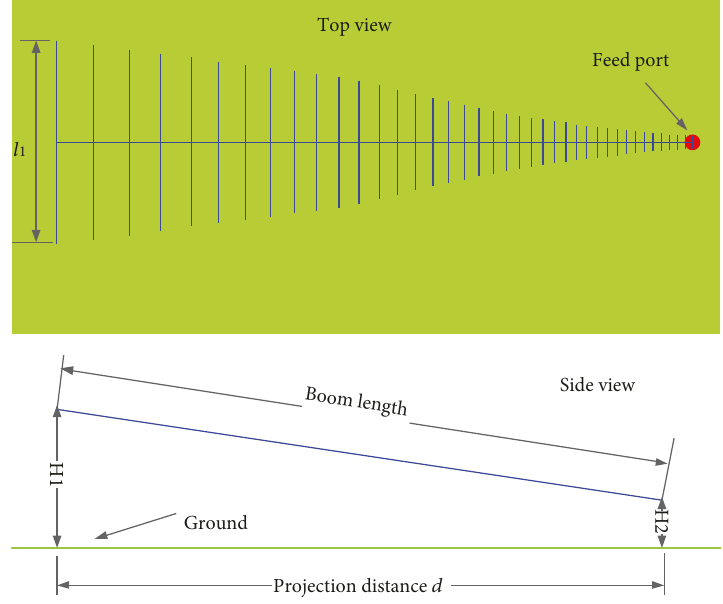
Figure 5: The model of the proposed nonlinear LPDA shortening dipoles 1 to 11. Table 1: The parameters of the proposed nonlinear LPDA.